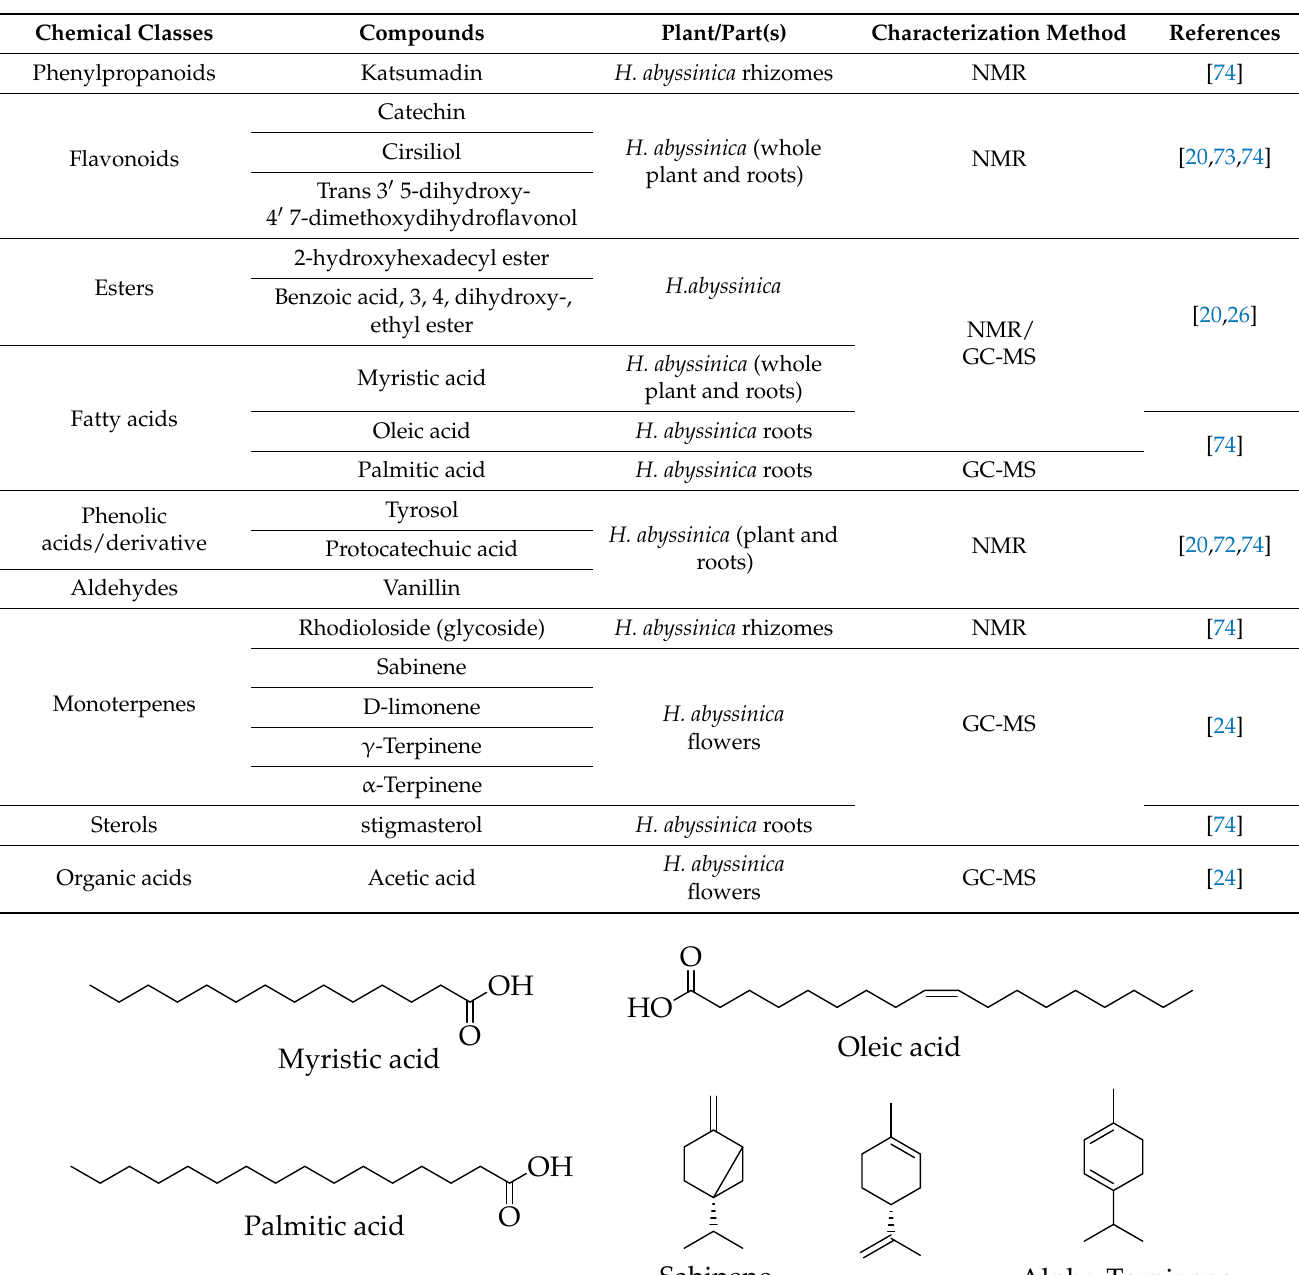
Table 3. Chemical compounds characterized in H. abyssinica.